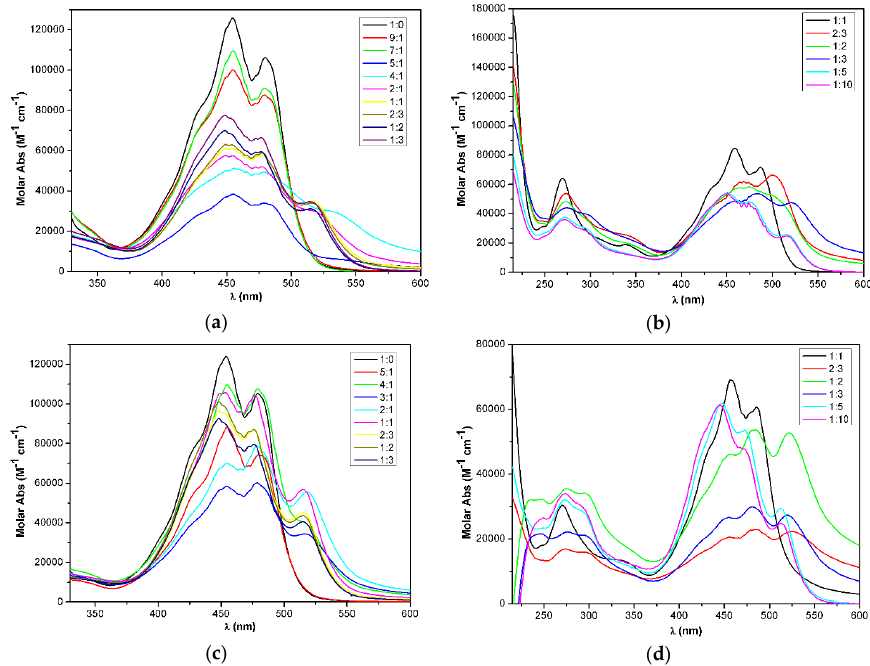
Figure 8. UV-vis spectra of chrysin–zeaxanthin conjugates of ( a ) the bistriazole 22 in acetone/water / water 1:1–1:10; ( c ) monotriazole 23 in acetone / water 1:0–1:3; 1:0–1:3; ( b ) bistriazole 22 in THF/water 1:1–1:10; ( c ) monotriazole 23 in acetone/water 1:0–1:3; ( d ) 1:0–1:3; ( b ) bistriazole 22 in THF ( d ) monotriazole 23 in THF / water